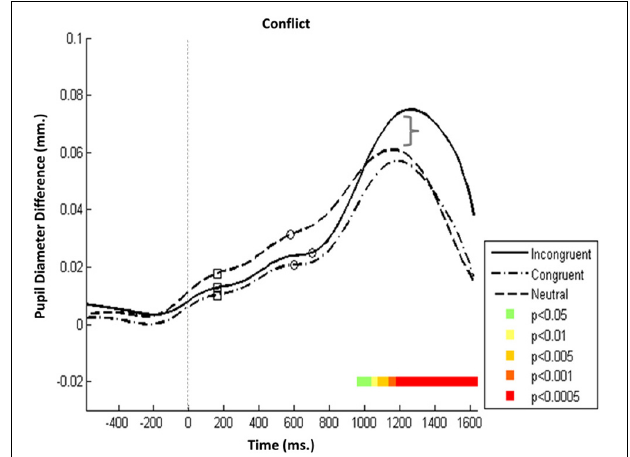
FIGURE 4 | Executive attention network—Mean PD dilation. Blue line, incongruent flankers trials; black line, congruent flankers trials; cyan line, neutral flankers trials; white squares, mean entrance to target AOI; white circles, mean response time. Time zero represents target onset (dashed gray line) and − 500ms cue onset (dotted gray